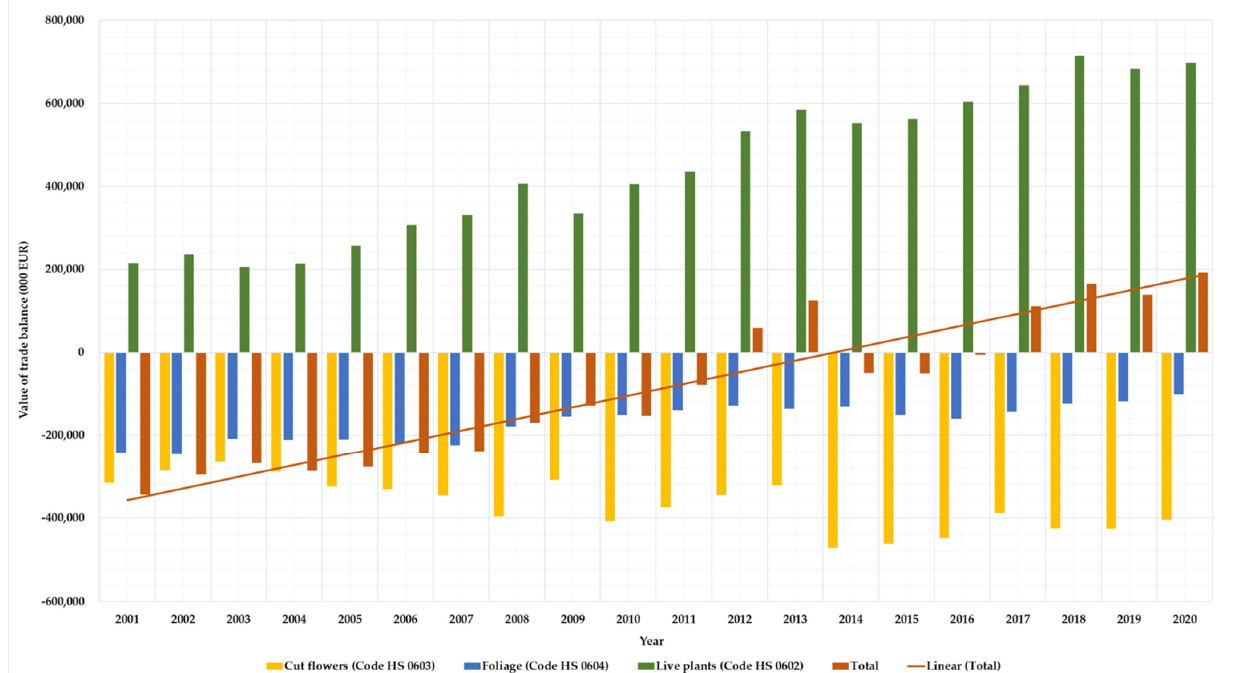
Figure 2. The European market for flowers and ornamental plants: EU (27) + UK trade balance (000 EUR, 2001–2020). Source: our elaboration on [51] (data extraction: 24th January 2022). The identified